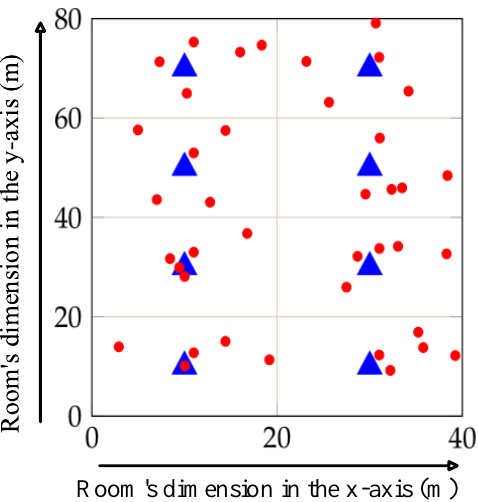
Figure 9. Layout of the Wi-Fi deployment in field